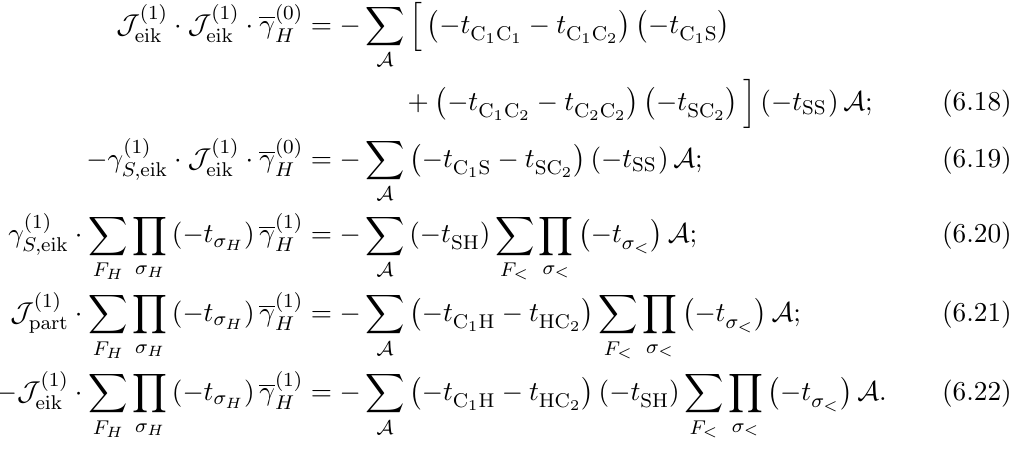
t t A is equal to a factorized C 1 H SS A